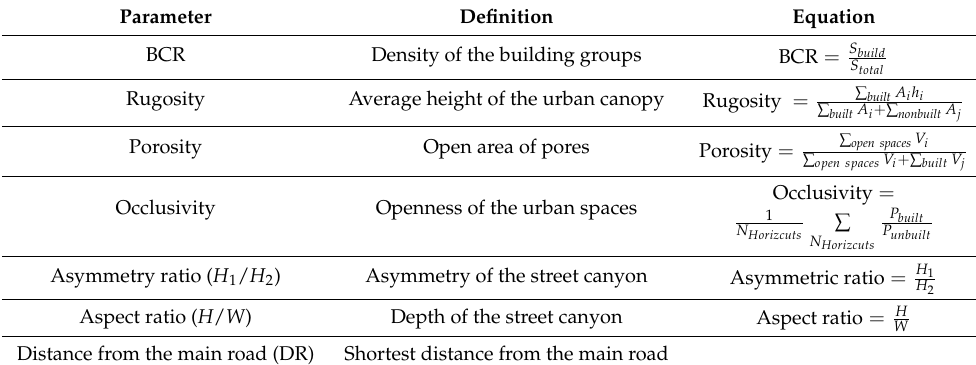
Table 1. Definition of the urban morphological